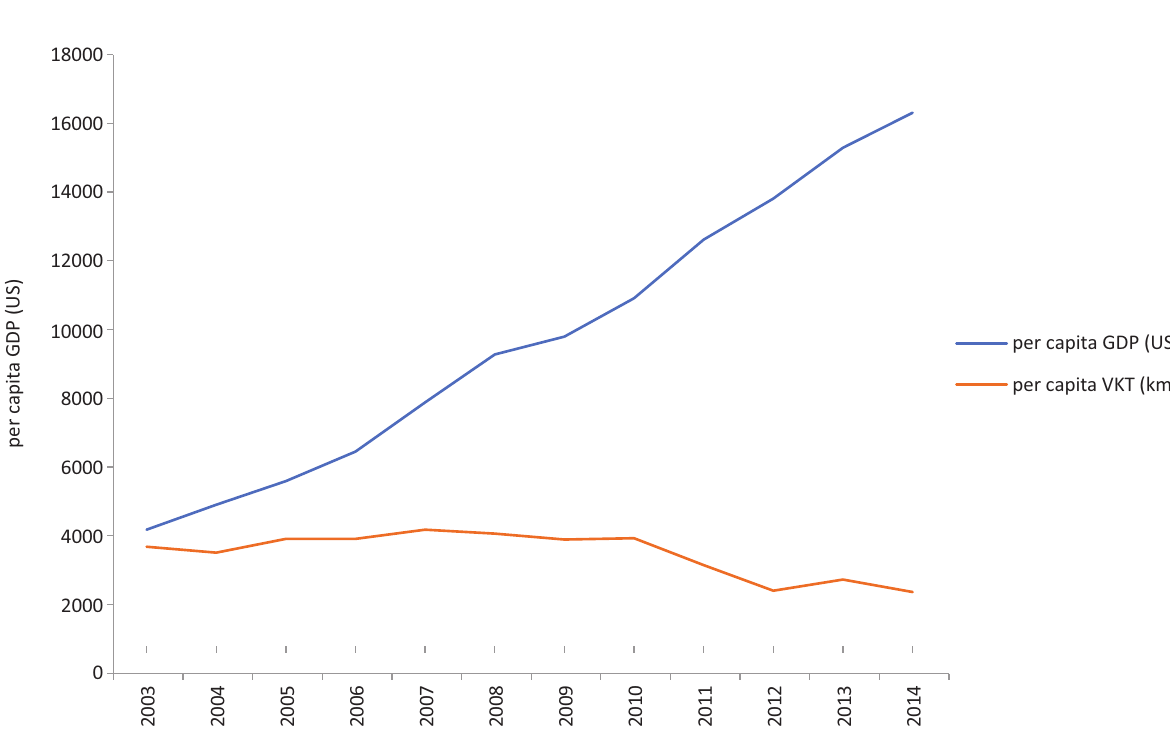
Figure 3. Peak car in Beijing: relationships between economic performance and private automobile use in Beijing from 1986 to 2014. Source: Compiled based on data provided by the Beijing Municipal Bureau of Statistics (BJMBS, 1982–2015, 2016) and the Beijing Transportation Research Centre (BJTRC, 2002–2014,